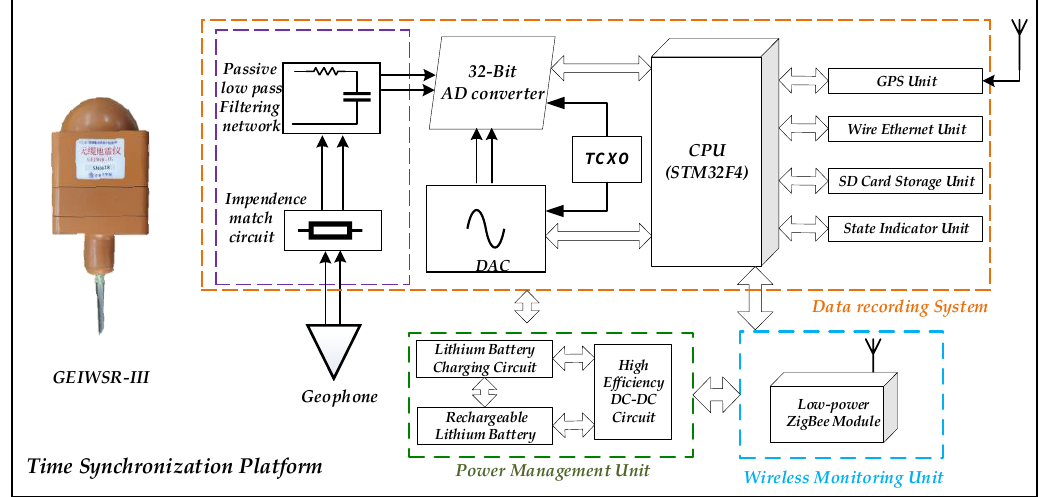
Figure 3. Block diagram of the time-synchronization platform GEIWSR-III.